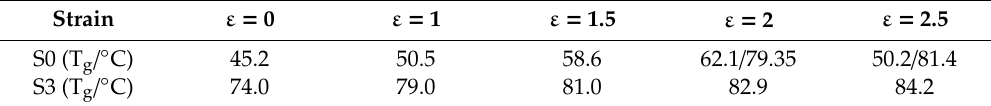
Table 3. The glass transition temperature of uniaxially stretched PA612 / SiO 2 films.